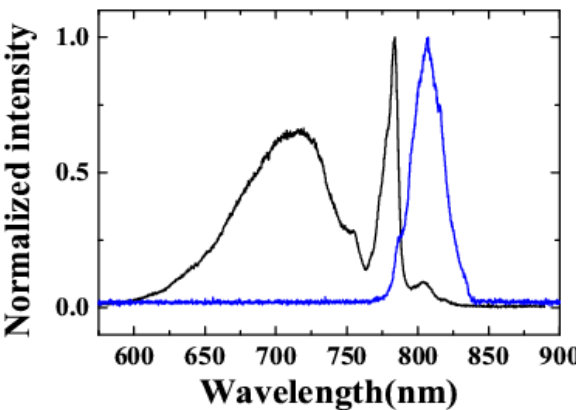
Figure 3. The spectra of the input beams prior to the fused silica glass plate. The black curve plots spectrum of beam1, while the blue curve plots spectrum of